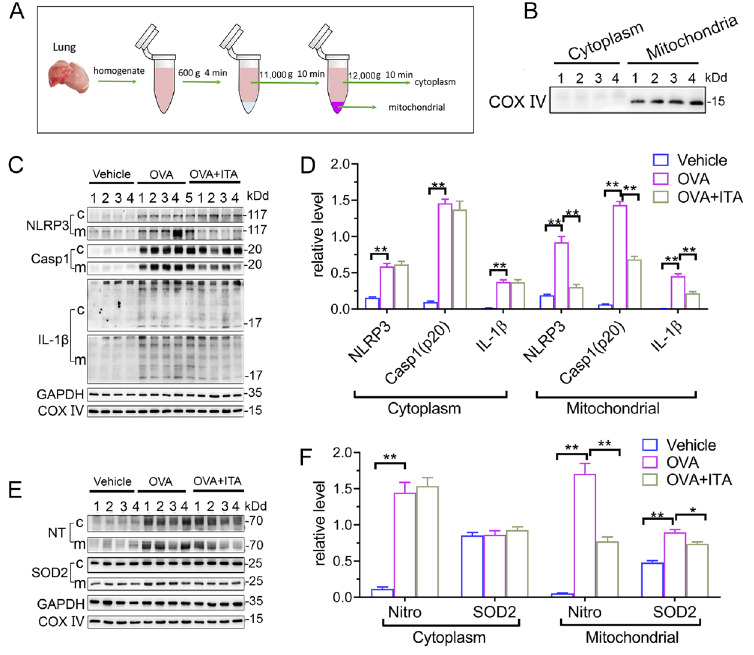
Figure 5. Itaconate suppresses mitochondrial NLRP3 inflammasome activation, oxidative stress and mitochondrial dynamics in allergic airway inflammation. ( A ) Protocol for mitochondrial and cytosolic protein fractionation of lung tissue. ( B ) Representative blots of COX IV in the mitochondrial and cytosolic fractions. ( C ) Representative blots of NLPR3, Caspase-1 (p20) and IL-1 β (p17) in cytosolic (c) and mitochondrial (m) fraction of lung tissue. ( D ) Quantitative analysis of NLPR3, Caspase-1 (p20) and IL-1 β (p17) in cytosolic and mitochondrial fraction. ( E ) Representative blots of nitrotyrosine (NT) and SOD2 in cytosolic and mitochondrial fraction of lung tissue. ( F ) Quantitative analysis of nitrotyrosine and SOD2 in the mitochondrial and cytosolic fractions. Cropped blots are shown, and Supplementary File S2: Figures S10–S12 presents the full-length blots. Data expressed as means ± SEM ( n = 6). * p < 0.05, ** p <